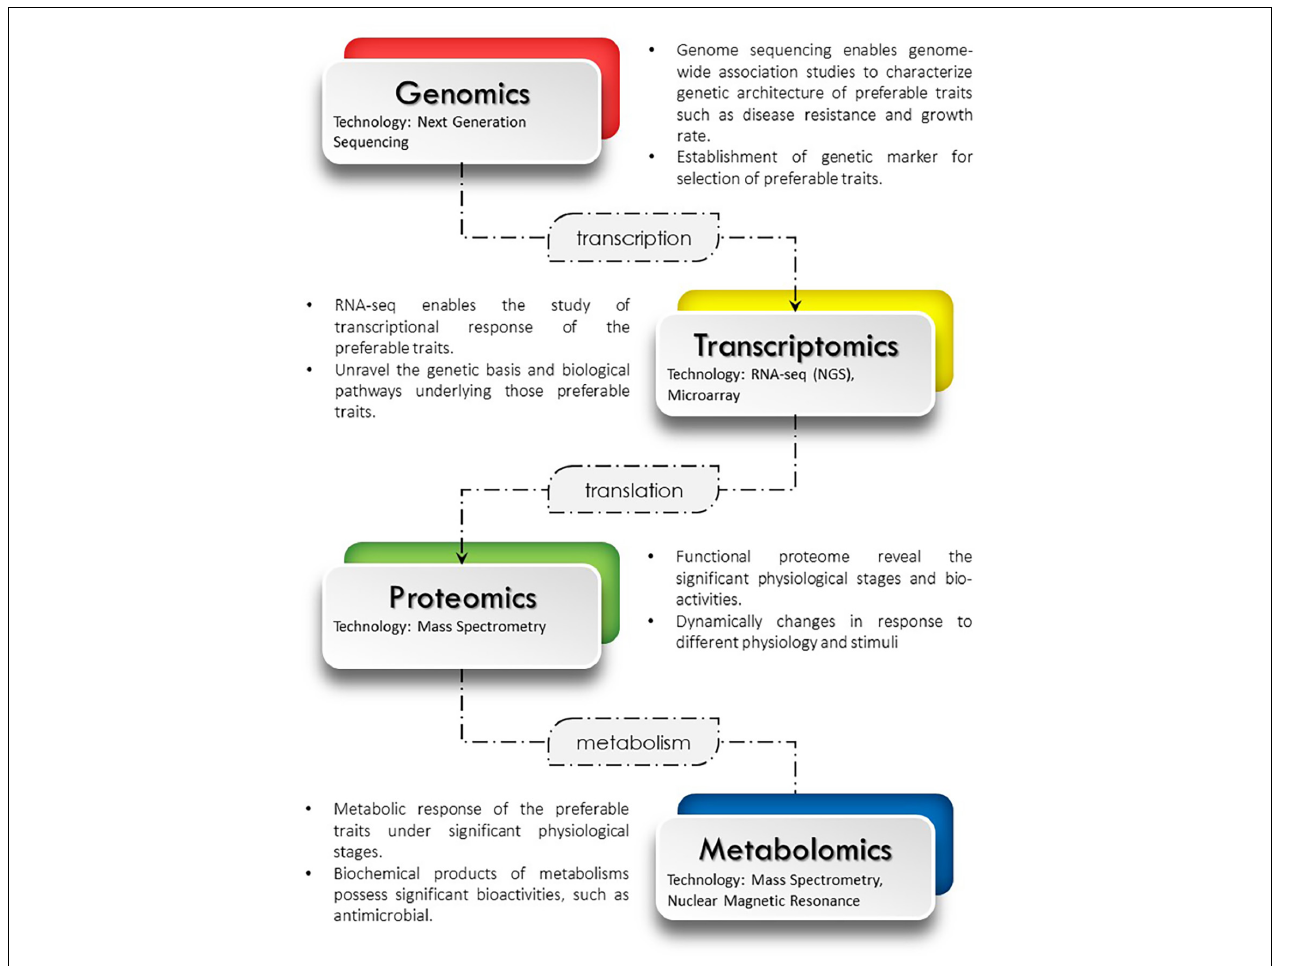
FIGURE 2 | Multi-omics integration of genomics, transcriptions, proteomics and